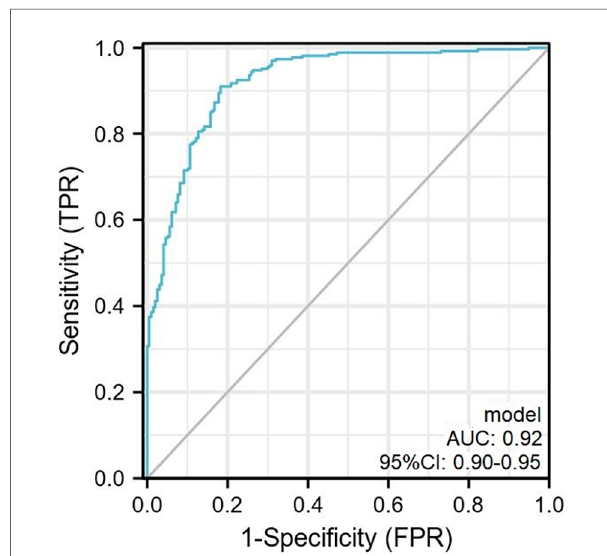
FIGURE 5 The ROC curve plotted according to the validation set. The AUC of the predictive model was 0.92 (95% CI: 0.90 – 0.95) with sensitivity and speci fi city of 91.0% and 81.7% in the validation set. ROC, receiver operator characteristic curve.